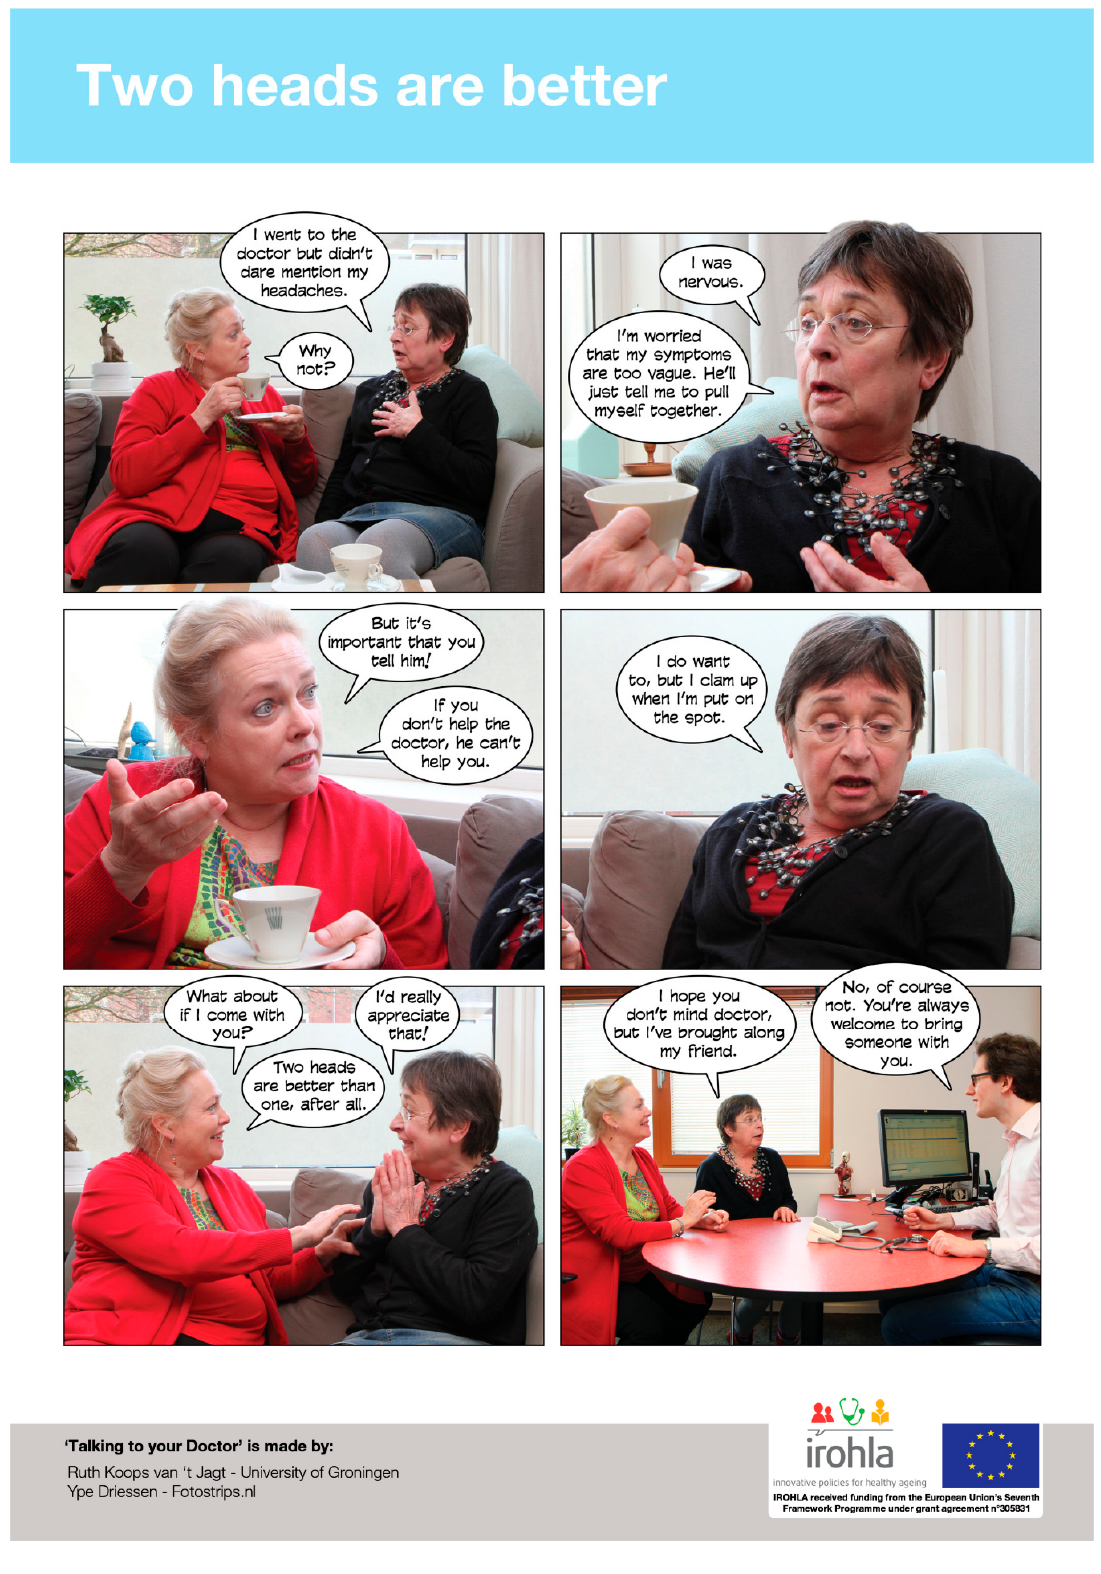
Figure 2. English version of the photo story about bringing someone for support.